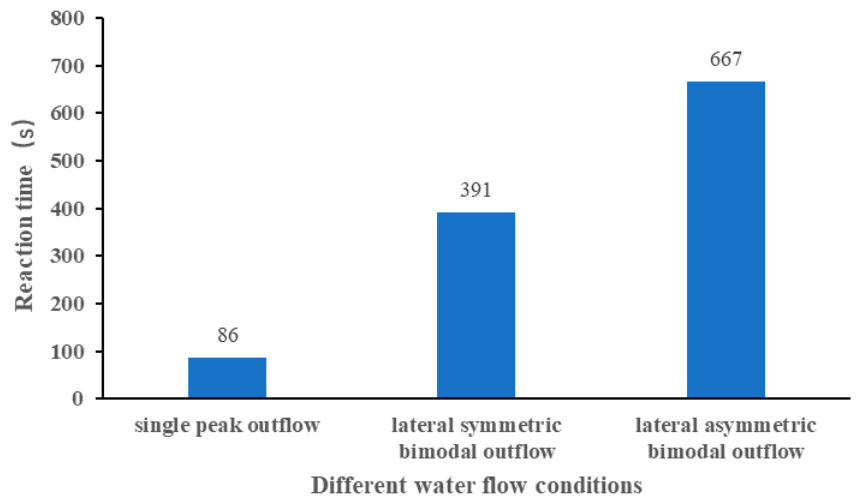
Figure 11. Average reaction time under different water flow conditions.